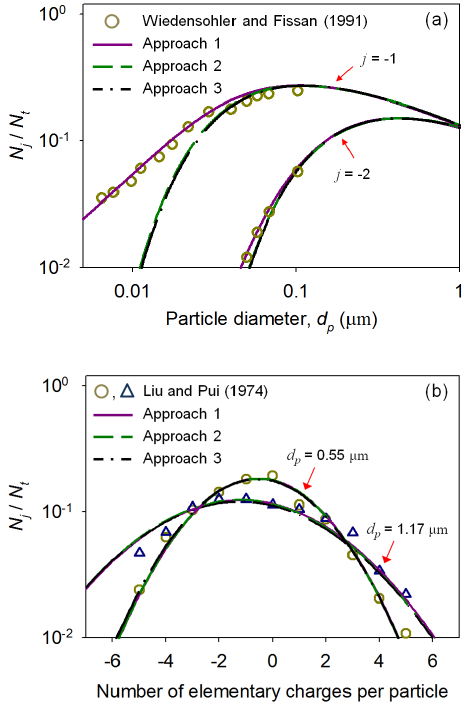
Figure 2. Steady-state charge distributions of particles capturing positive and negative ions. The symbols represent the measurements of the charge distributions of particles.